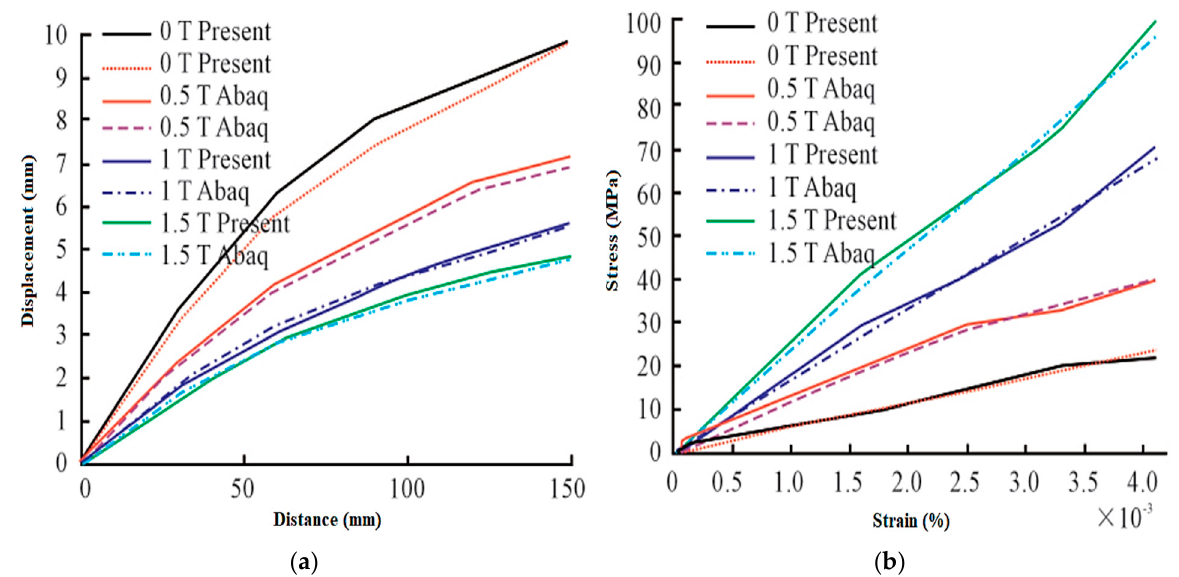
Figure 20. Stiffness and the damping characteristics of the sandwich beams. ( a ) Displacements Vs magnetic field intensities and ( b ) Stress strain curves.